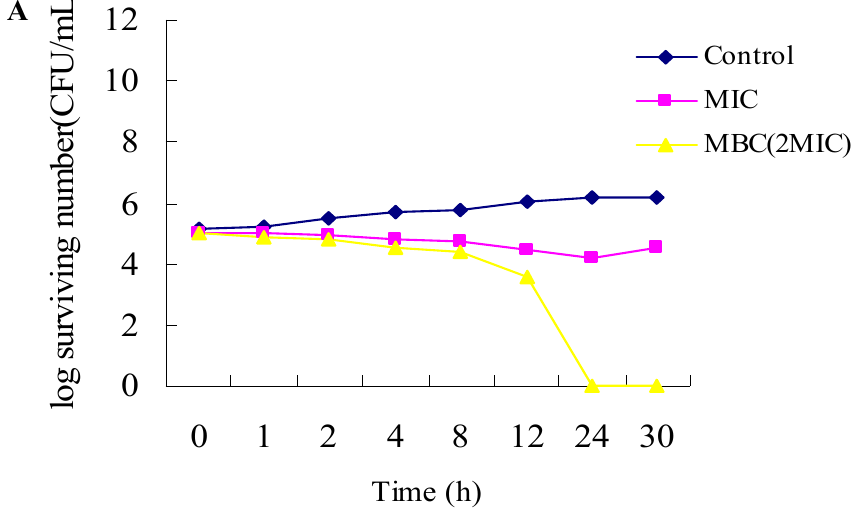
Figure 1. Time-kill curves of R. officinalis L. essential oil and three of its main components towards Staphylococcus aureus . ( A ) The concentrations used for R. officinalis L. essential oil were: 0.0313% (MIC) and 0.0625% (2MIC, MBC); ( B ) The concentrations used for α -pinene were MIC (0.0313%), 2MIC (0.0625%) and MBC (0.125%); ( C )